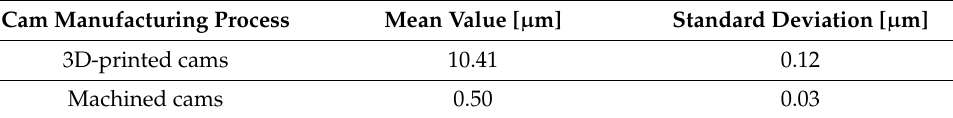
Table 5. Average surface roughness R a for the 3D-printed and machined